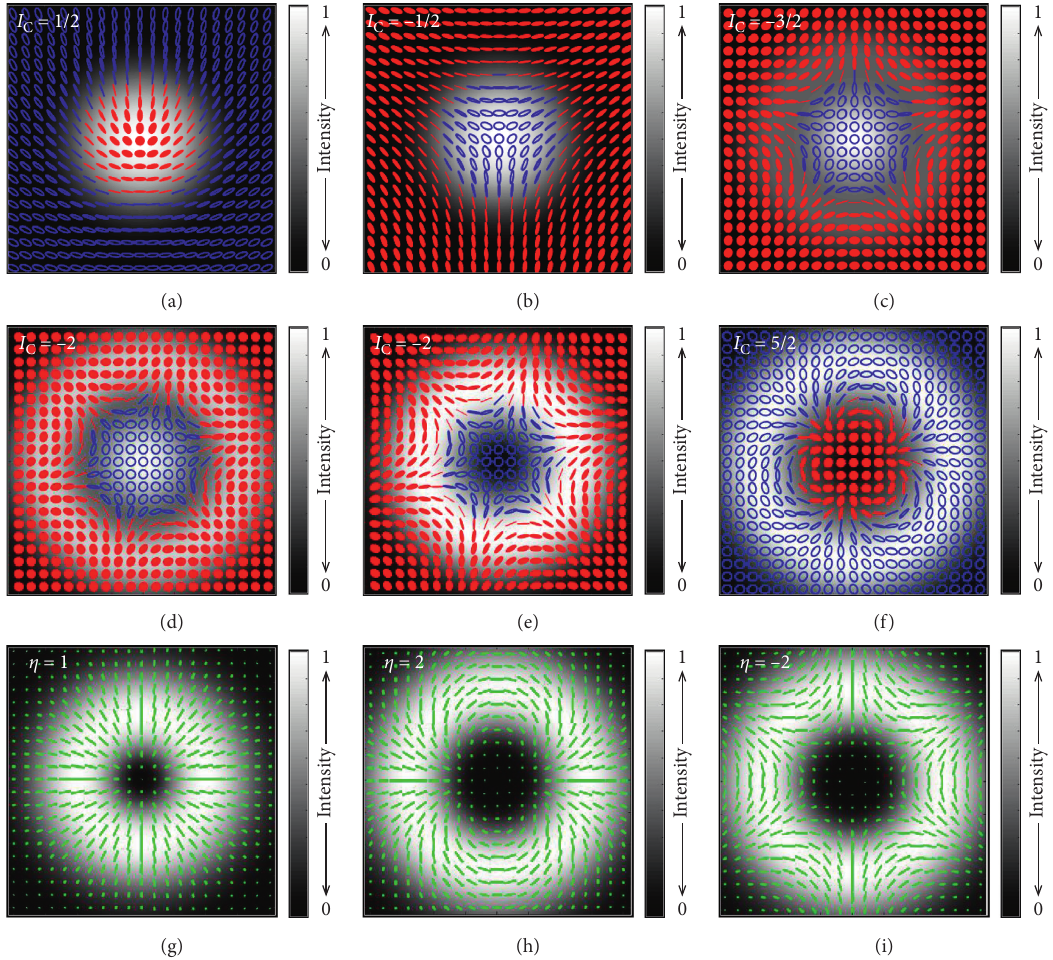
Figure 5: Polarization distributions containing (a–f) C-points and (g–i) V-points. Indices of C-points and V-points are mentioned above each figure. (a) and (b) are generic C-points and are commonly known as lemon and star, respectively. (a–d) Bright C-points; (e-f) dark C- points. Note that, in (d) and (e), a C-point with the same index can be dark or bright. V-points always occur at zero intensity. (g) A generic V-point known as radially polarized; (h) a polarization flower; (i) a spider web.